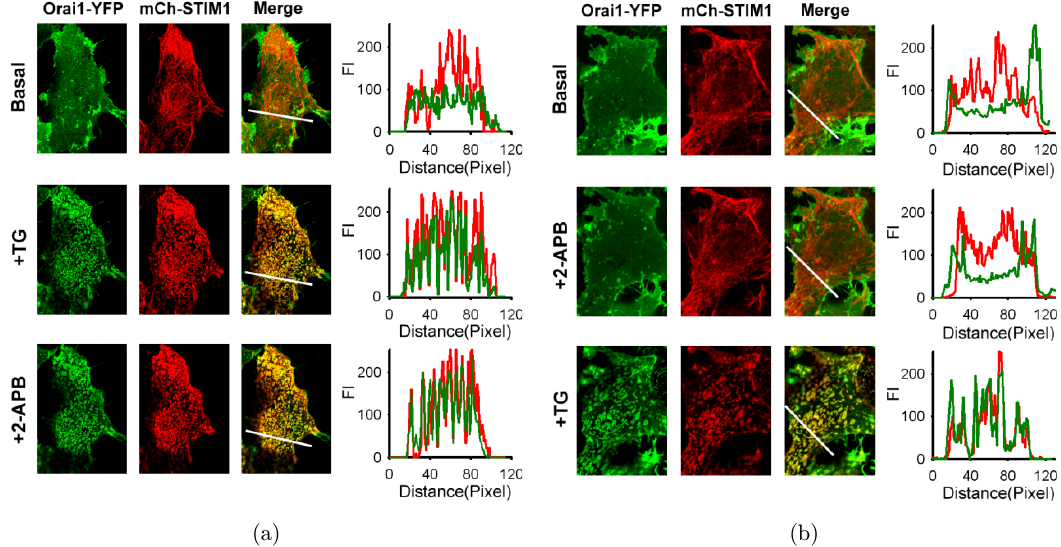
Fig. 4. 2-APB cannot reverse or prevent STIM1 localization in near plasma membrane puncta in HEK293 cells expressing mCherry-STIM1 and Orai1-eYFP. (a) After Ca 2 þ store depletion, mCherry-STIM1 and Orai1-eYFP formed colocalized puncta ( þ TG); 50 (cid:1) M 2-APB failed to disperse these colocalized puncta in HEK293 cells ( þ 2-APB). The right panels show spatial pro¯les of °uorescence intensity of Orai1-eYFP (green) and mCherry-STIM1 (red) along the lines imposed on the images. (b) Cells co- expressing mCherry-STIM1 with Orai1-eYFP and pretreated with 50 (cid:1) M 2-APB for 5 min showed signi¯cant formation of colo- calized puncta after TG